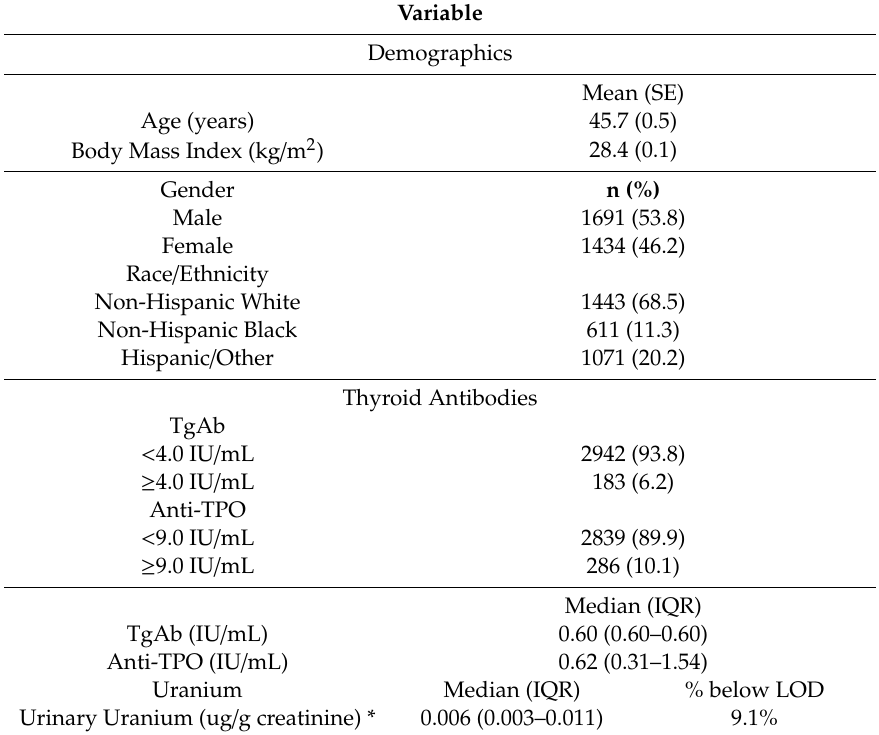
Table 1. Description of the National Health and Nutrition Examination Survey (NHANES) population under study (n =